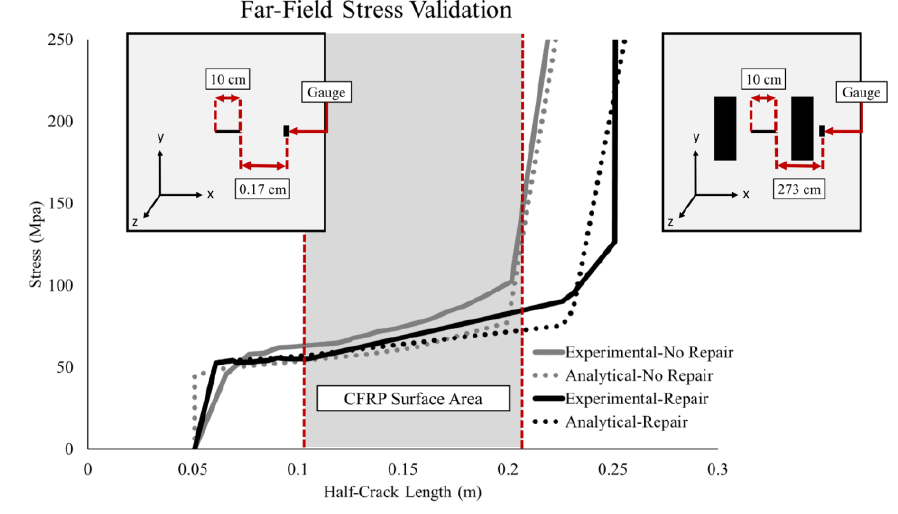
Figure 7. Far-field stress result.